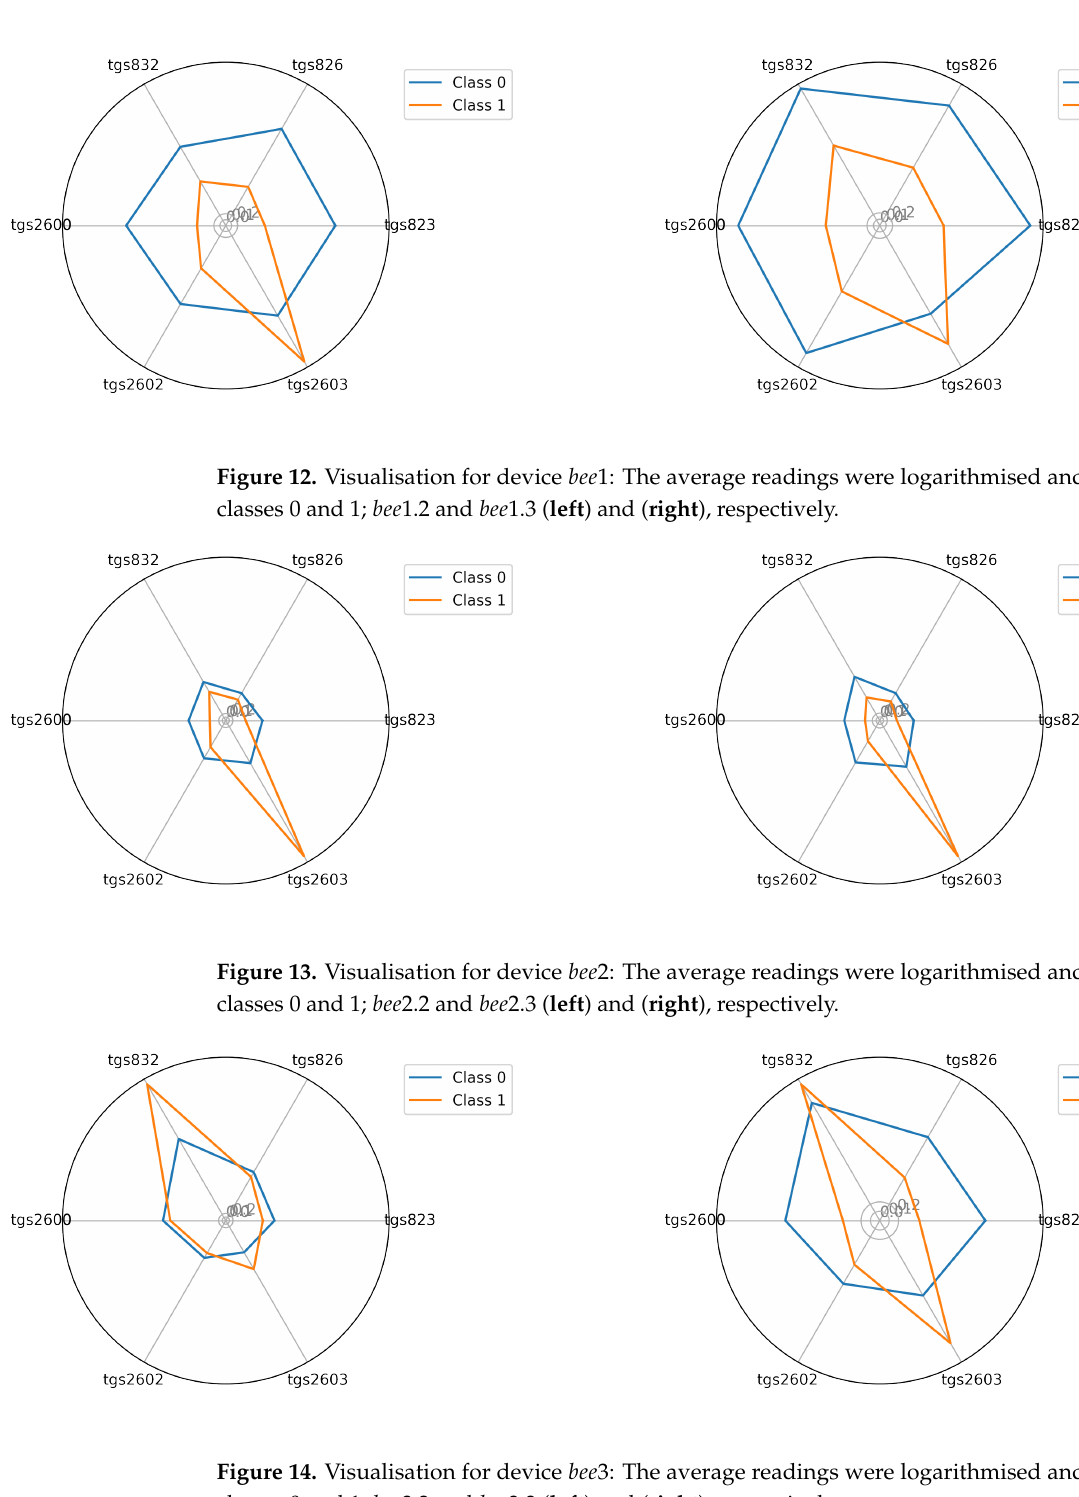
Figure 14. Visualisation for device bee 3: The average readings were logarithmised and squared in classes 0 and 1; bee 3.2 and bee 3.3 ( left ) and ( right ),